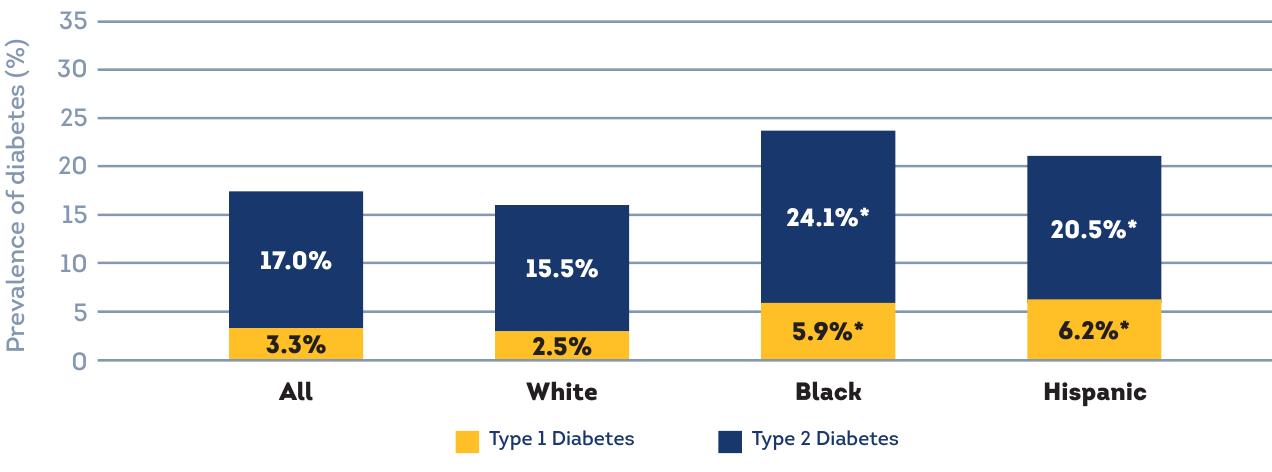
Figure 1. Percentage of community-dwelling Medicare beneficiaries with self-reported diagnosed diabetes, by race/ethnicity and type of diabetes